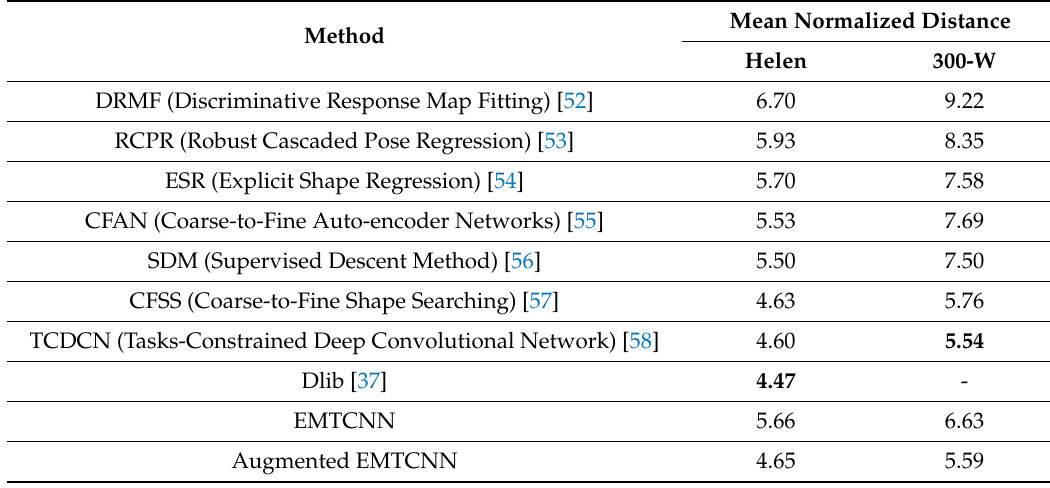
Table 3. Comparison of mean normalized